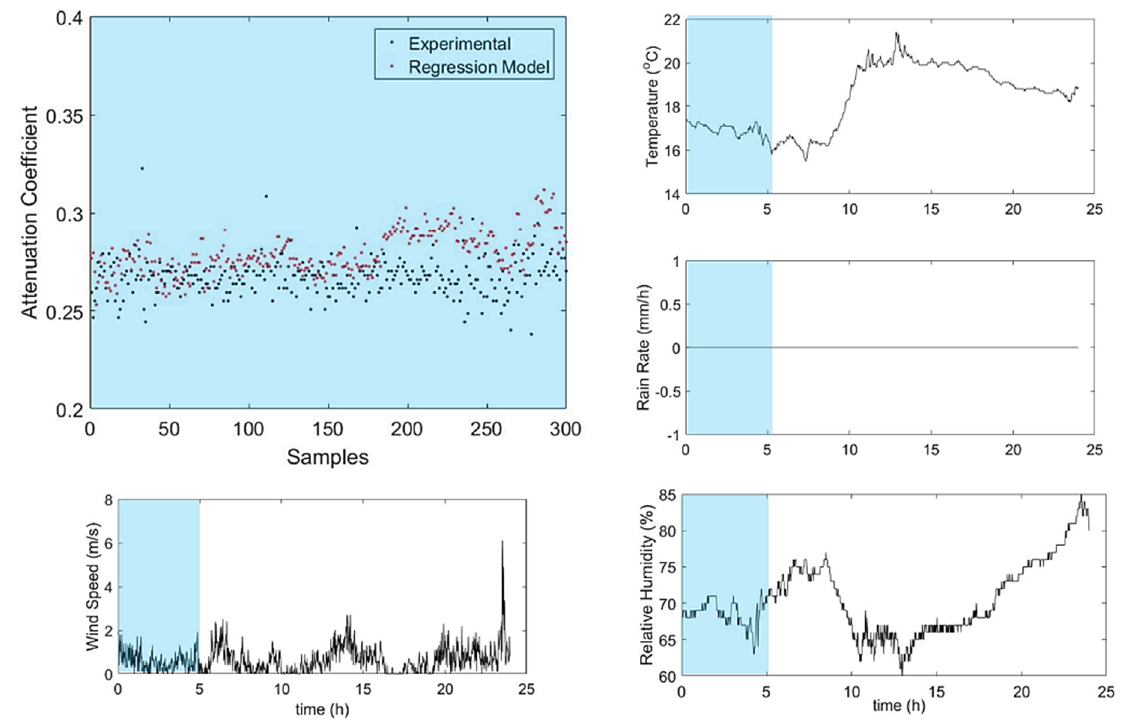
Figure 11. Experimental measurements and model predictions, i.e., Equation (6), for 17 November 2019. Table 5. R 2 values for several